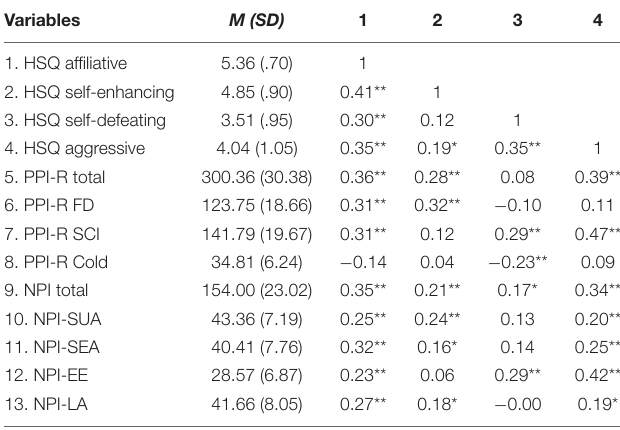
TABLE 1 | Mean, standard deviations and intercorrelations among study variables ( N =